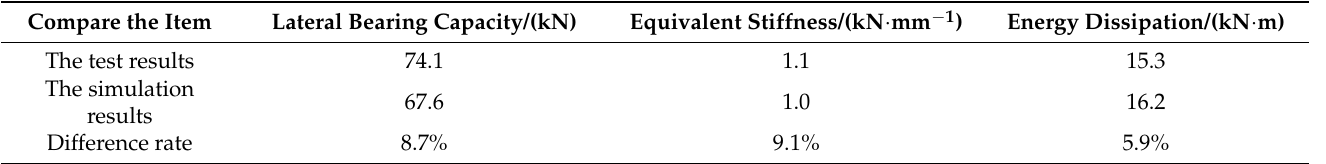
Table 3. Comparison between simulation results and test